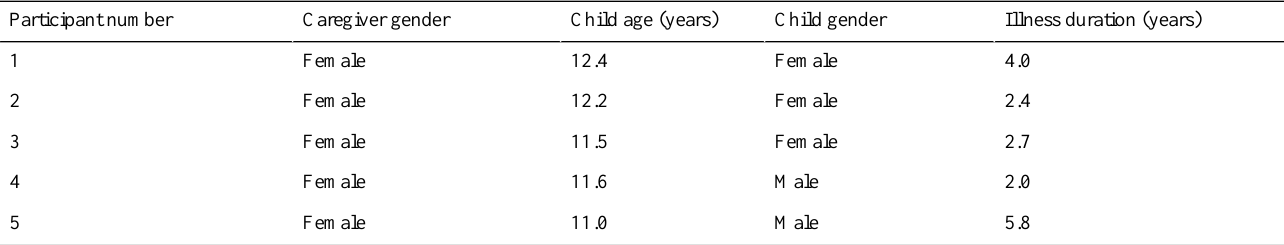
Table 1. Participant